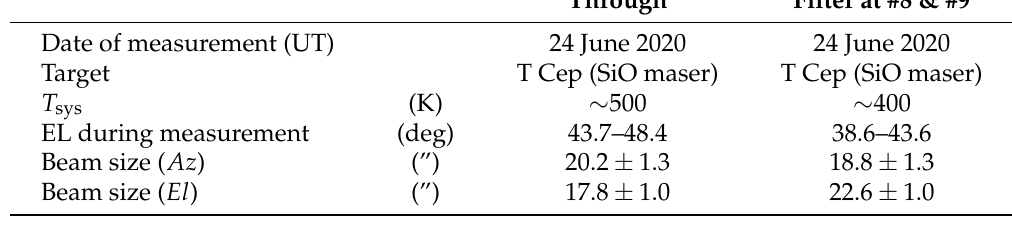
Table 5. Beam sizes for vertical polarization obtained with 86-GHz observing system. Through Filter at #8 & #9